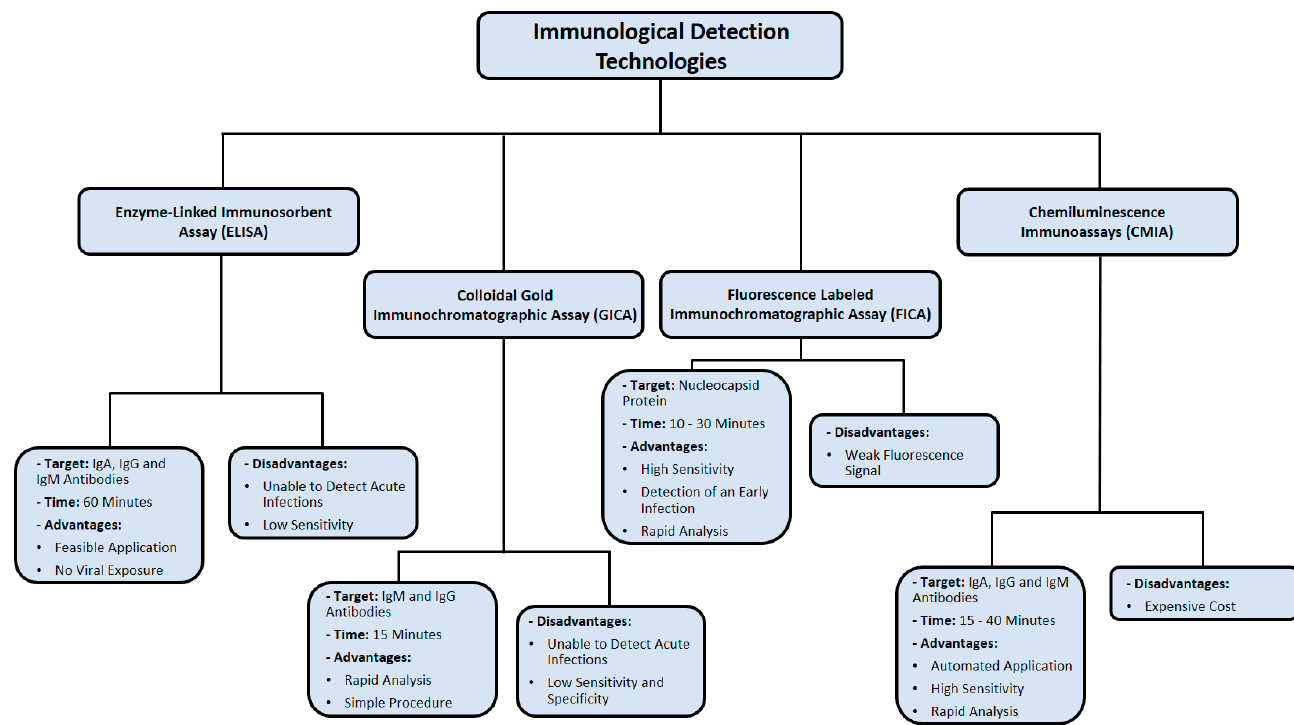
Figure 5. Summary of immunological detection methods used in diagnosing SARS-CoV-2 infection. Data were obtained from several published reports [76–79,84–86,90,91,96,97].